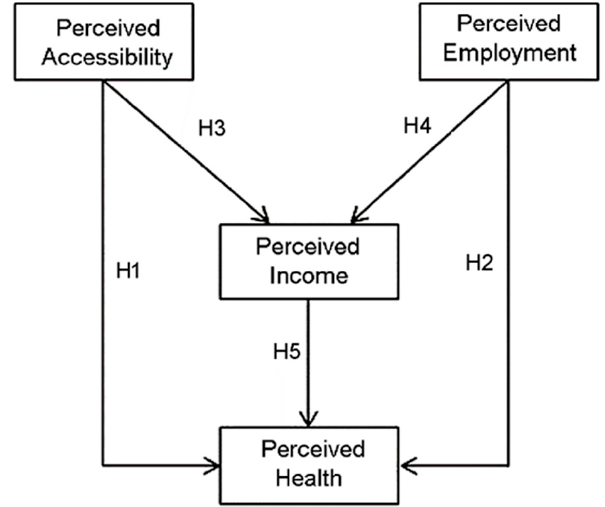
Figure 1. Hypothetical Model.